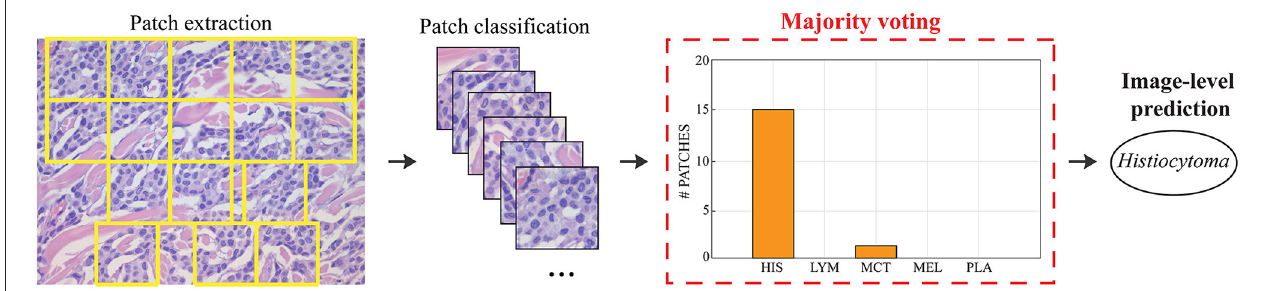
FIGURE 3 | Steps for obtaining the image classification during testing. Patches are extracted based on local nuclear density. Each patch is fed into the deep learning model and the final classification is obtained using majority voting.